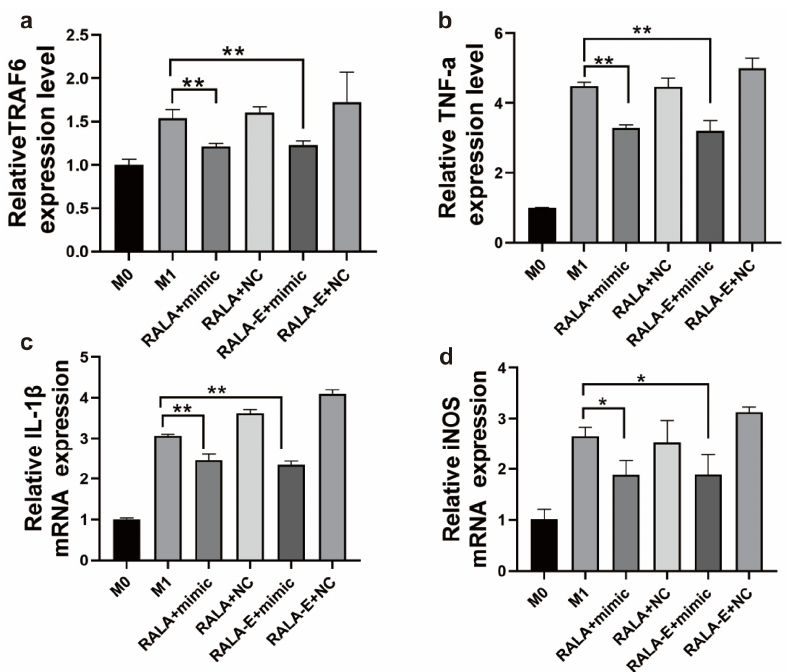
Figure 7. Relative mRNA expression of ( a ) TRAF6, ( b ) TNF- α , ( c ) IL-1 β , ( d ) iNOS of M1 macrophages 24 h post-transfection by RALA-E/miR-146a. N = 3. ** p ≤ 0.01. * p ≤ 0.05.